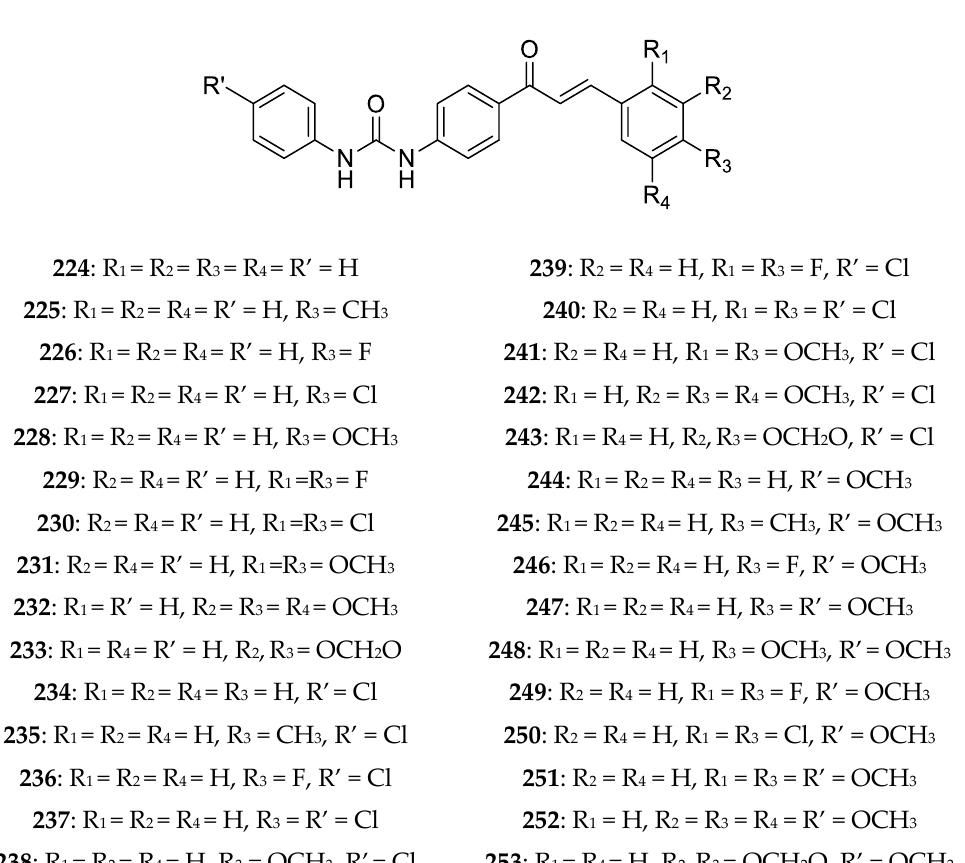
Figure 70. Chemical structure and side chains of N -acyl-4-aminochalcone derivatives with substitution on ring B.